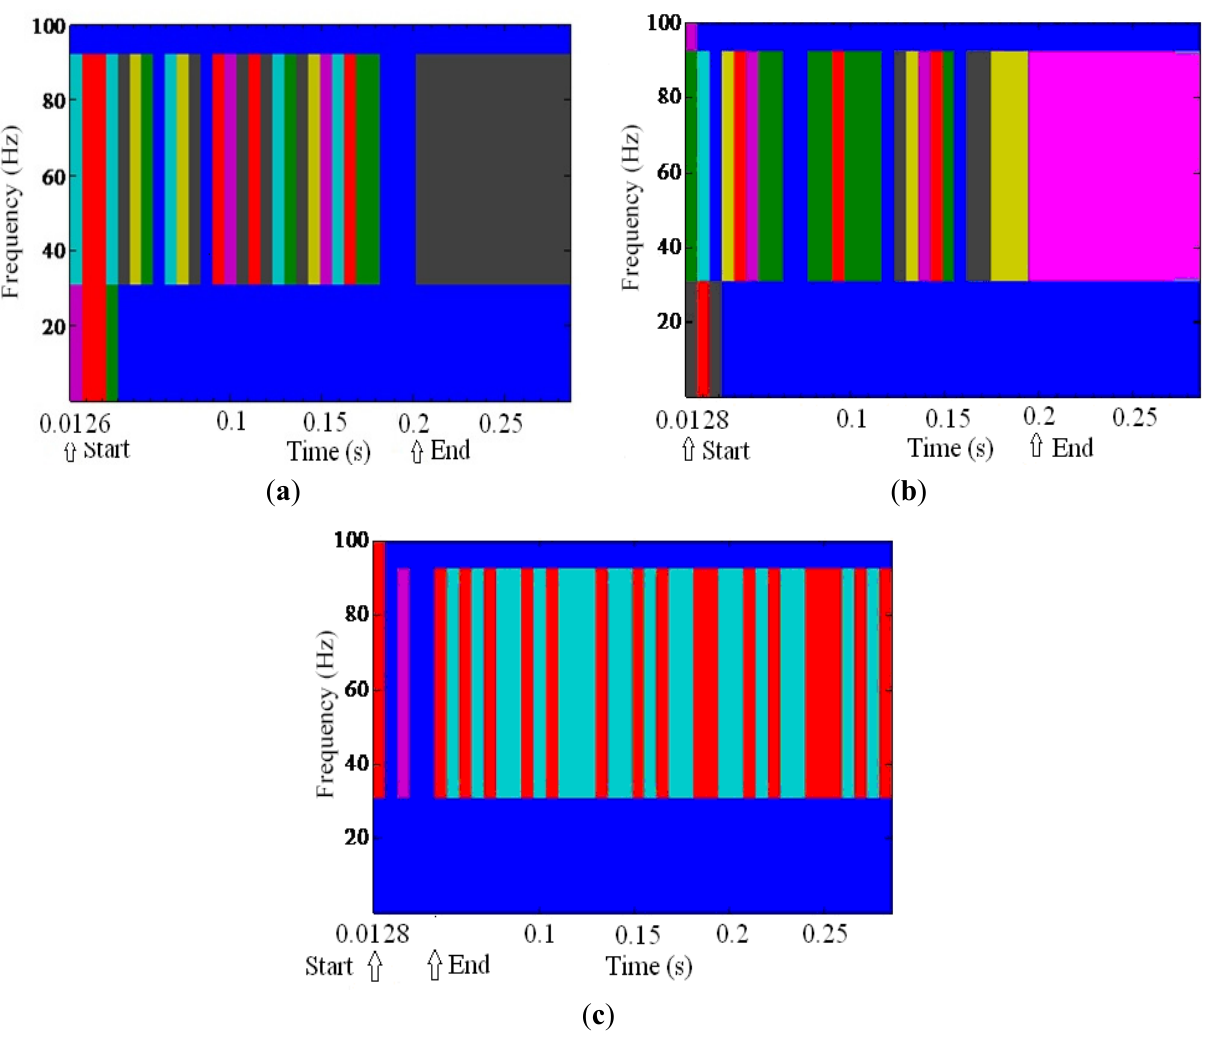
Figure 5. The STFT results of turn-on current transients. ( a ) a 160-hp induction motor; ( b ) a 123-hp induction motor driven by variable-voltage drives; ( c ) a bank of loads supplied by a six-pulse thyristor rectifier for AC